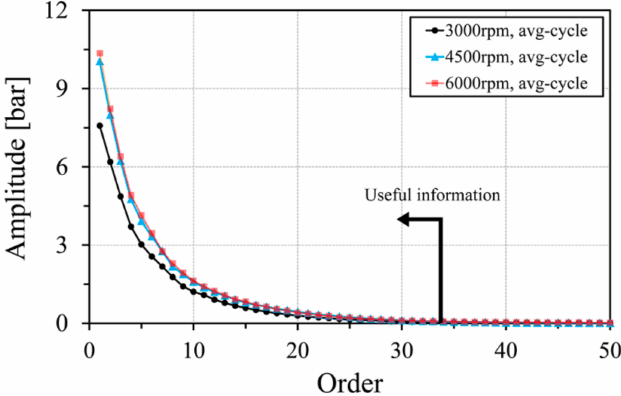
Figure 4. FFT spectrum of the pressure sensor signal at full load and different engine speeds.